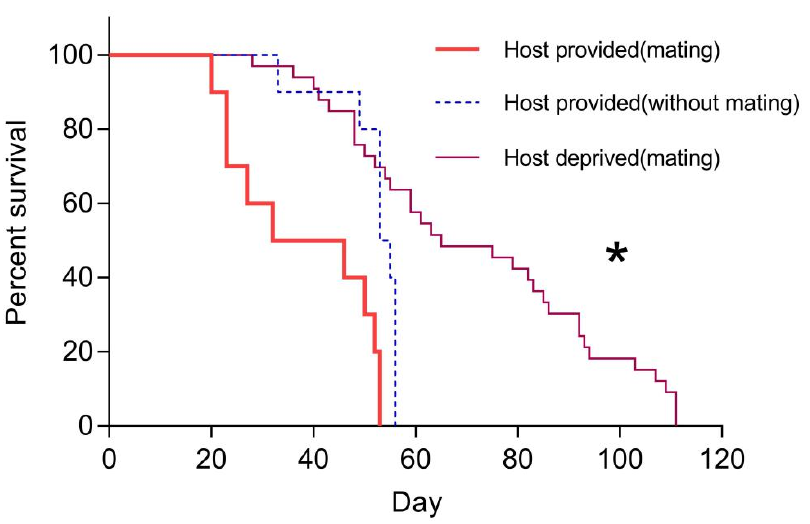
Figure 5. Survival percentages for adult T. drosophilae females under host-deprived and